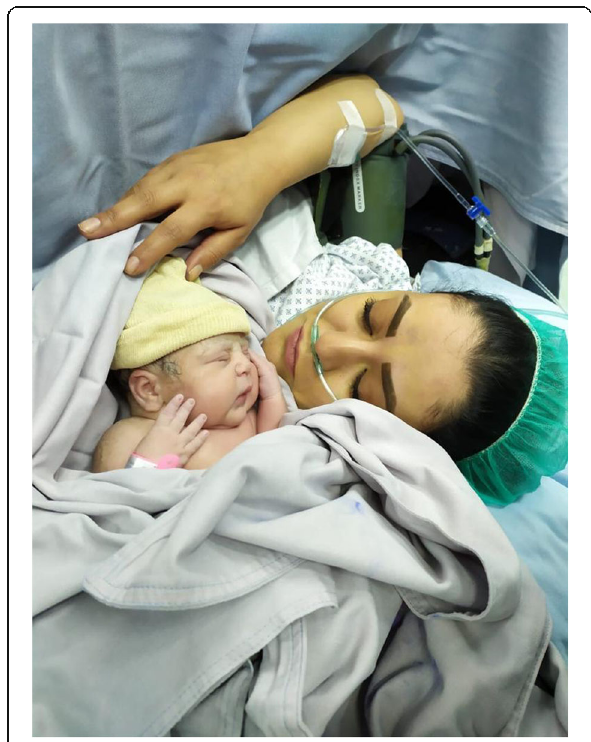
Fig. 2 The newborn baby after birth on January 13,